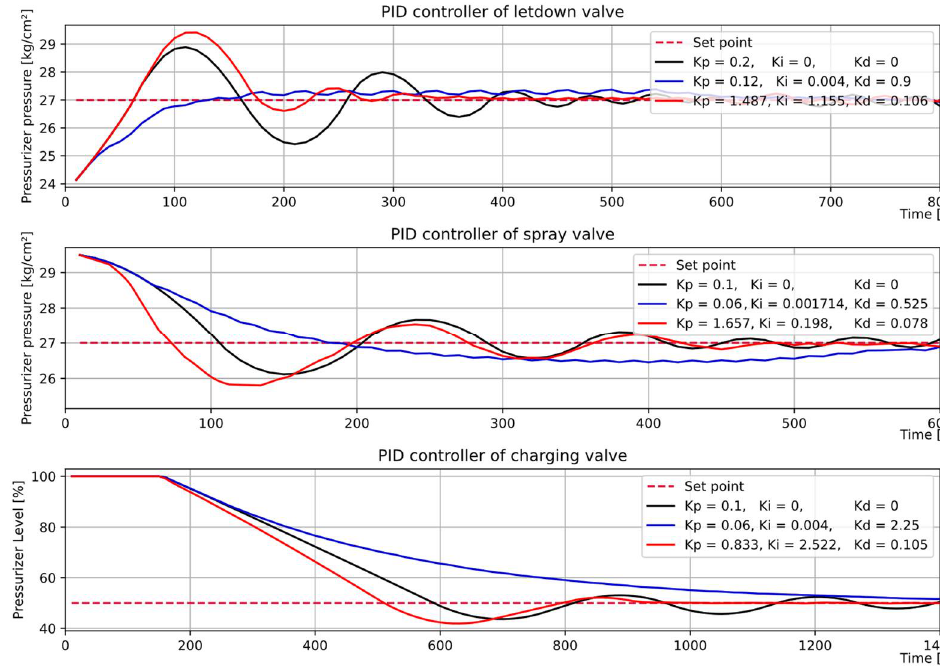
Figure 19. Comparison of performances for the different tuning methods.